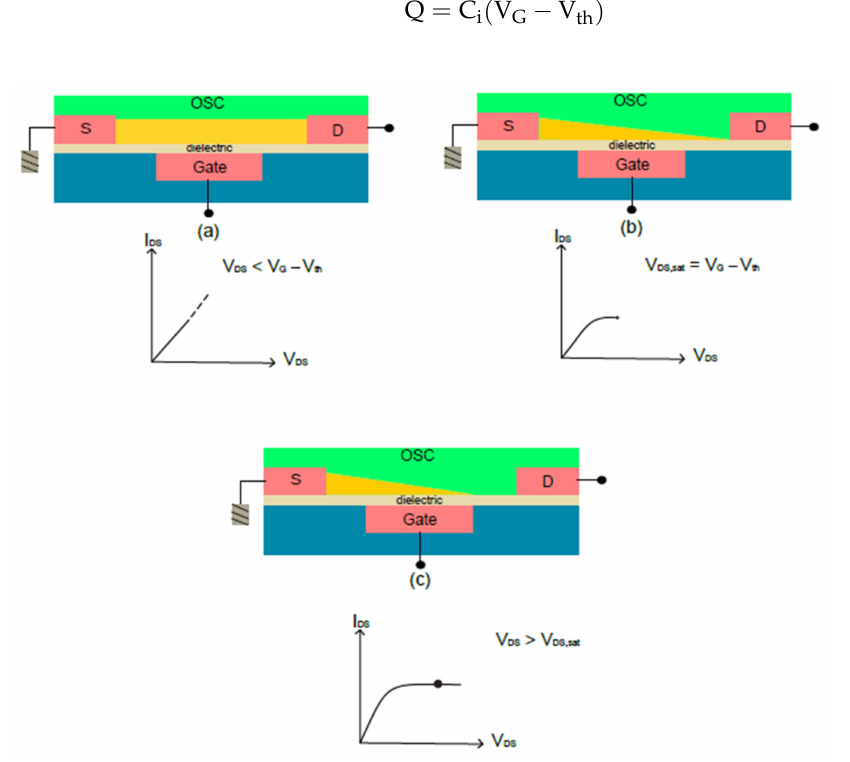
Figure 6. Illustrations of operating modes of OFETs, ( a ) linear regime, ( b ) start of saturation regime, ( c ) the channel pinch-off and saturation